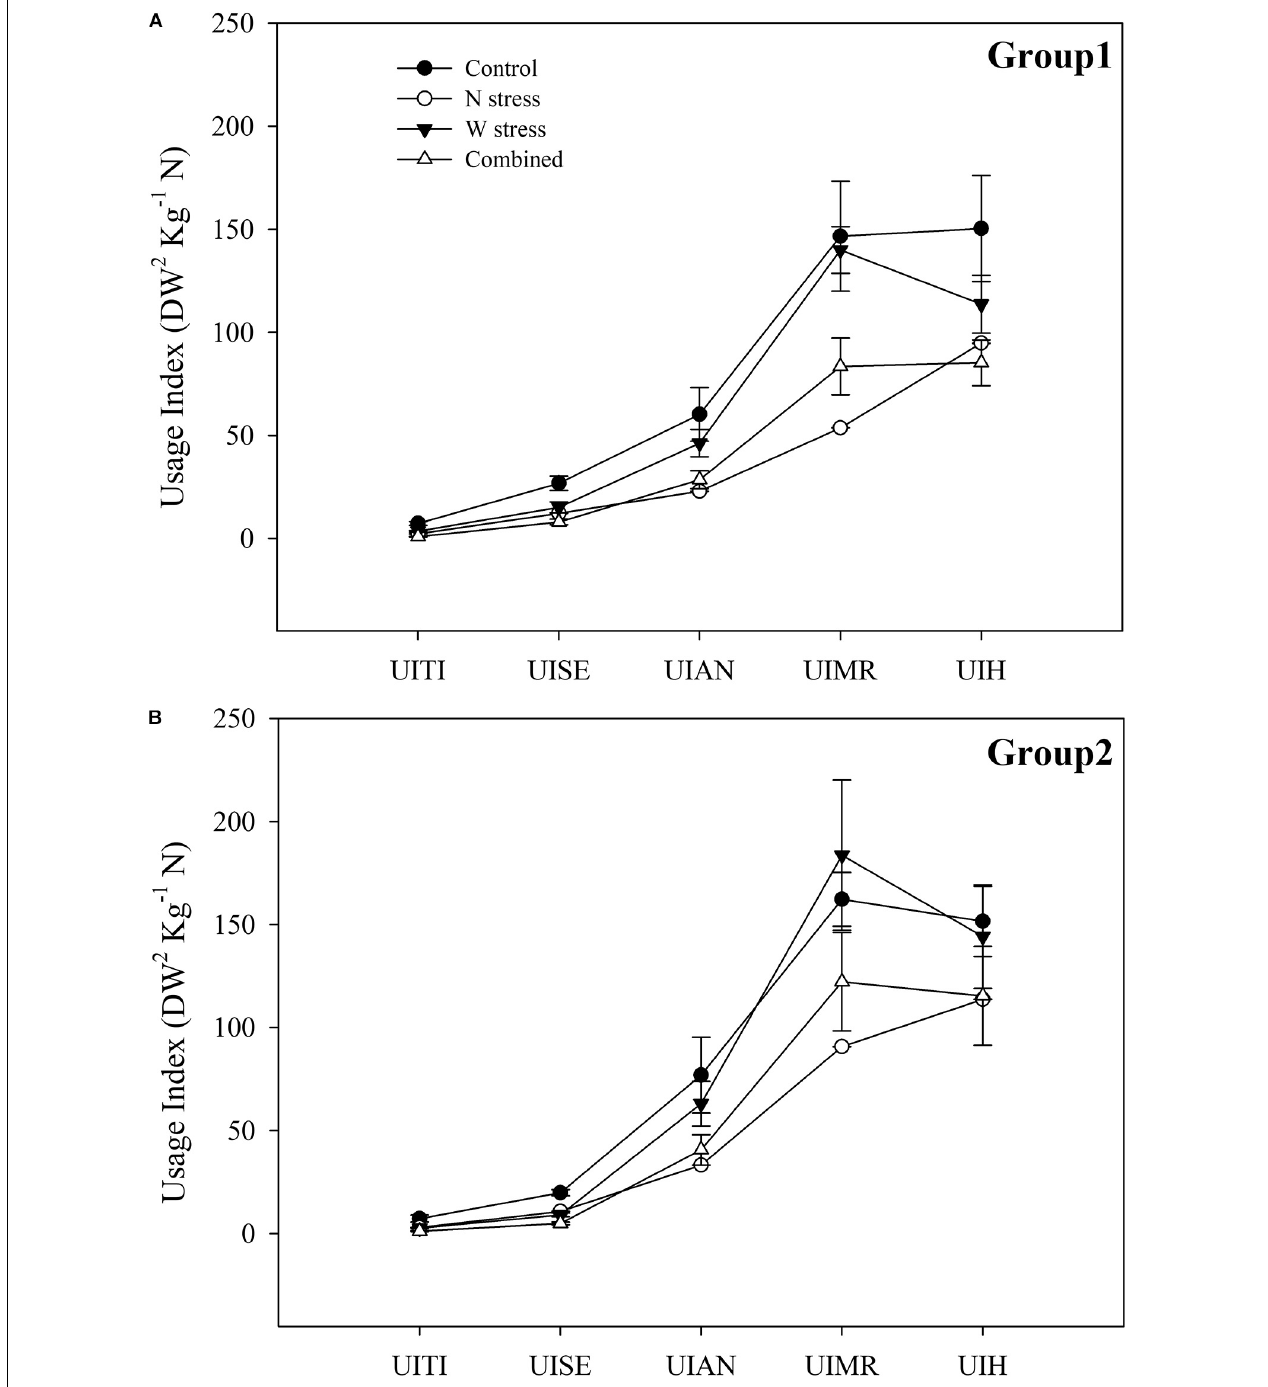
FIGURE 7 | Usage index of nitrogen during phenological stages of durum wheat genotypes. Group 1: Messapia, Tiziana, Svevo, and Normanno (A) and group 2: Russello, Mazzancoio, Cappelli, and Capeiti (B) calculated according to Siddiqi and Glass (1981). UITI, usage index at tillering; UISE, usage index stem extension; UIAN, usage index at anthesis; UIMR, usage index at milk ripening; UIH, usage index at